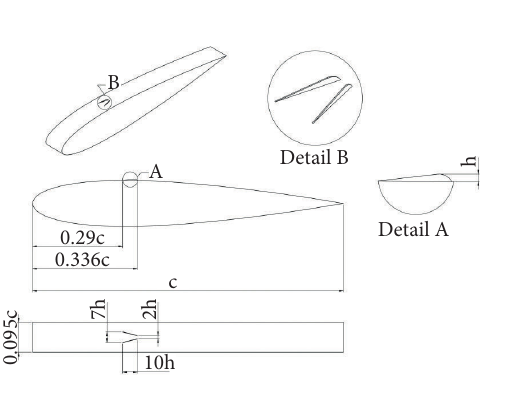
Figure 1. Sizing of vortex